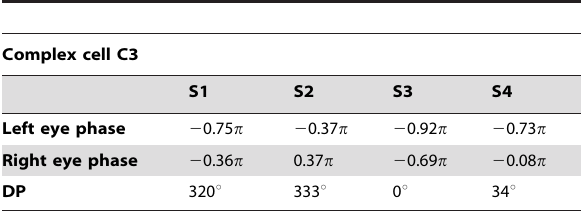
Table 3. Modeled simple cell 1D RF profile phases for complex cell C3.